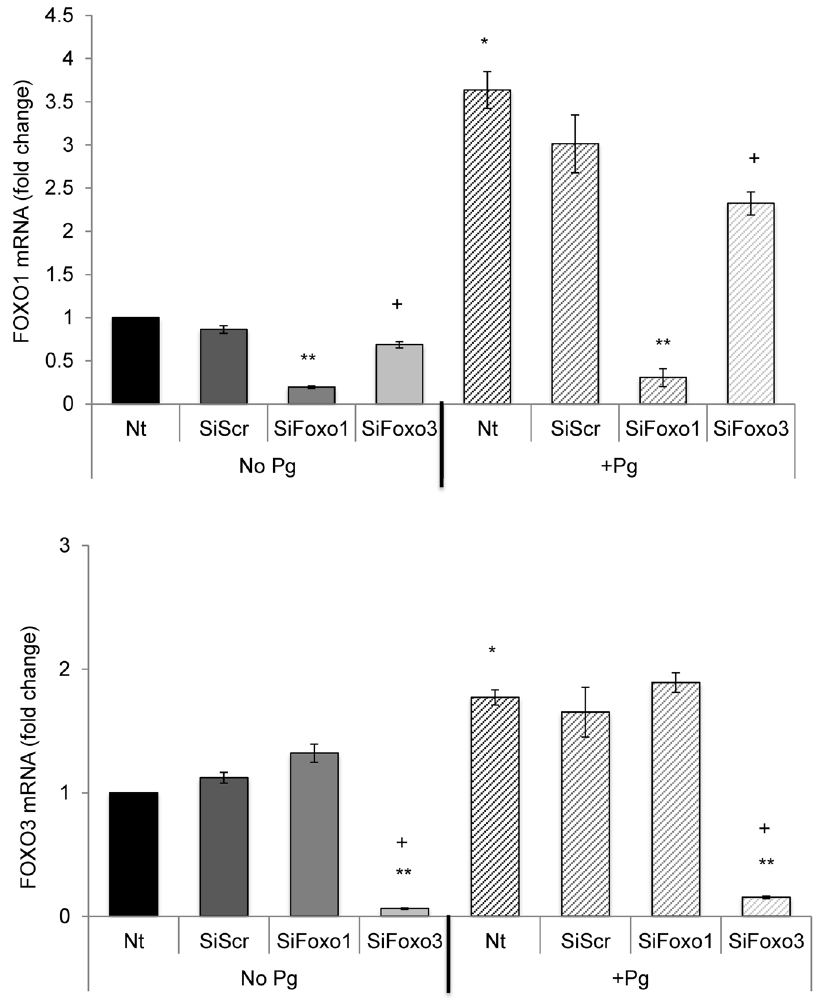
Figure 5. P.gingivalis up-regulates FOXO1 and FOXO3 mRNA levels. Primary human gingival epithelial cell cultures were incubated with or without P. gingivalis at MOI=1:50 for 20 hrs. In some cases cells were pre-incubated with FOXO1 siRNA (SiFOXO1), FOXO3 siRNA (SiFOXO3) or scrambled siRNA (SiScr) FOXO1 prior to stimulation with bacteria. FOXO1 and FOXO3 mRNA levels were measured by real-time PCR. * Significantly different from control cells without bacterial stimulation (P , 0.05). ** Significantly different between scrambled siRNA and FOXO1 or FOXO3 siRNA (P , 0.05). + Significantly different between FOXO1 siRNA and FOXO3 siRNA (P , 0.05).